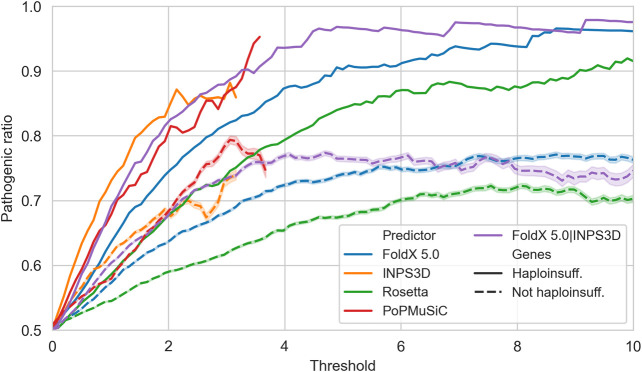
Precision (y-axis) of the protein stability-based methods in predicting pathogenicity at different |ΔΔG| values, defined as the ratio of truly pathogenic over all the variants reporting predicted |ΔΔG| values above a specific threshold (x-axis). Solid and dashed lines are computed on variants in haploinsufficient and non-haploinsufficient genes, respectively. INPS3D and PoPMuSiC lines stop earlier since the methods do not provide predictions with |ΔΔG| values greater than the reported thresholds.